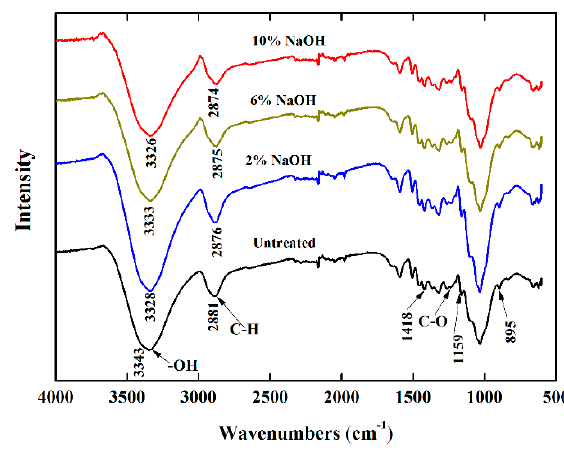
Figure 8. FT-IR spectra of untreated and 2–10 wt.% NaOH treated bamboo fibers.